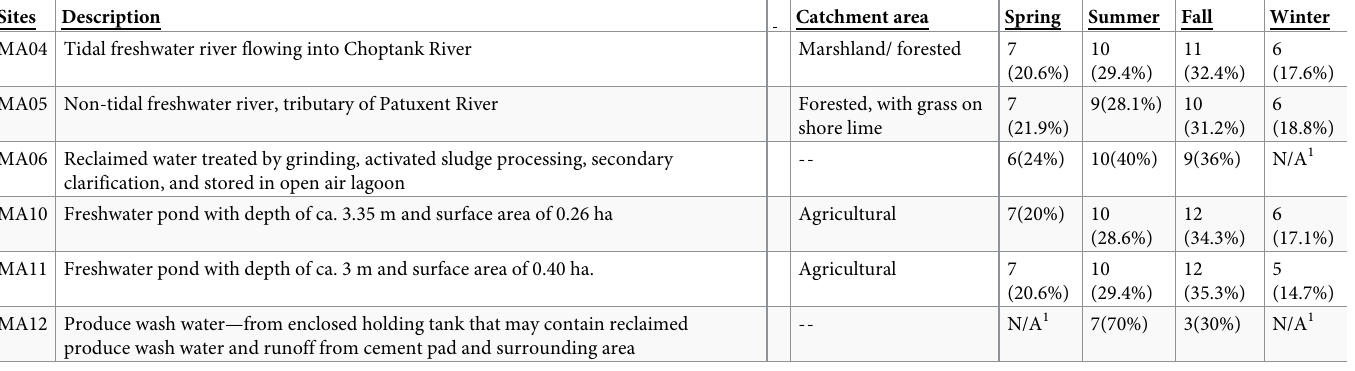
Table 1. Description of sites and number of surface or reclaimed water samples taken by season, Fall